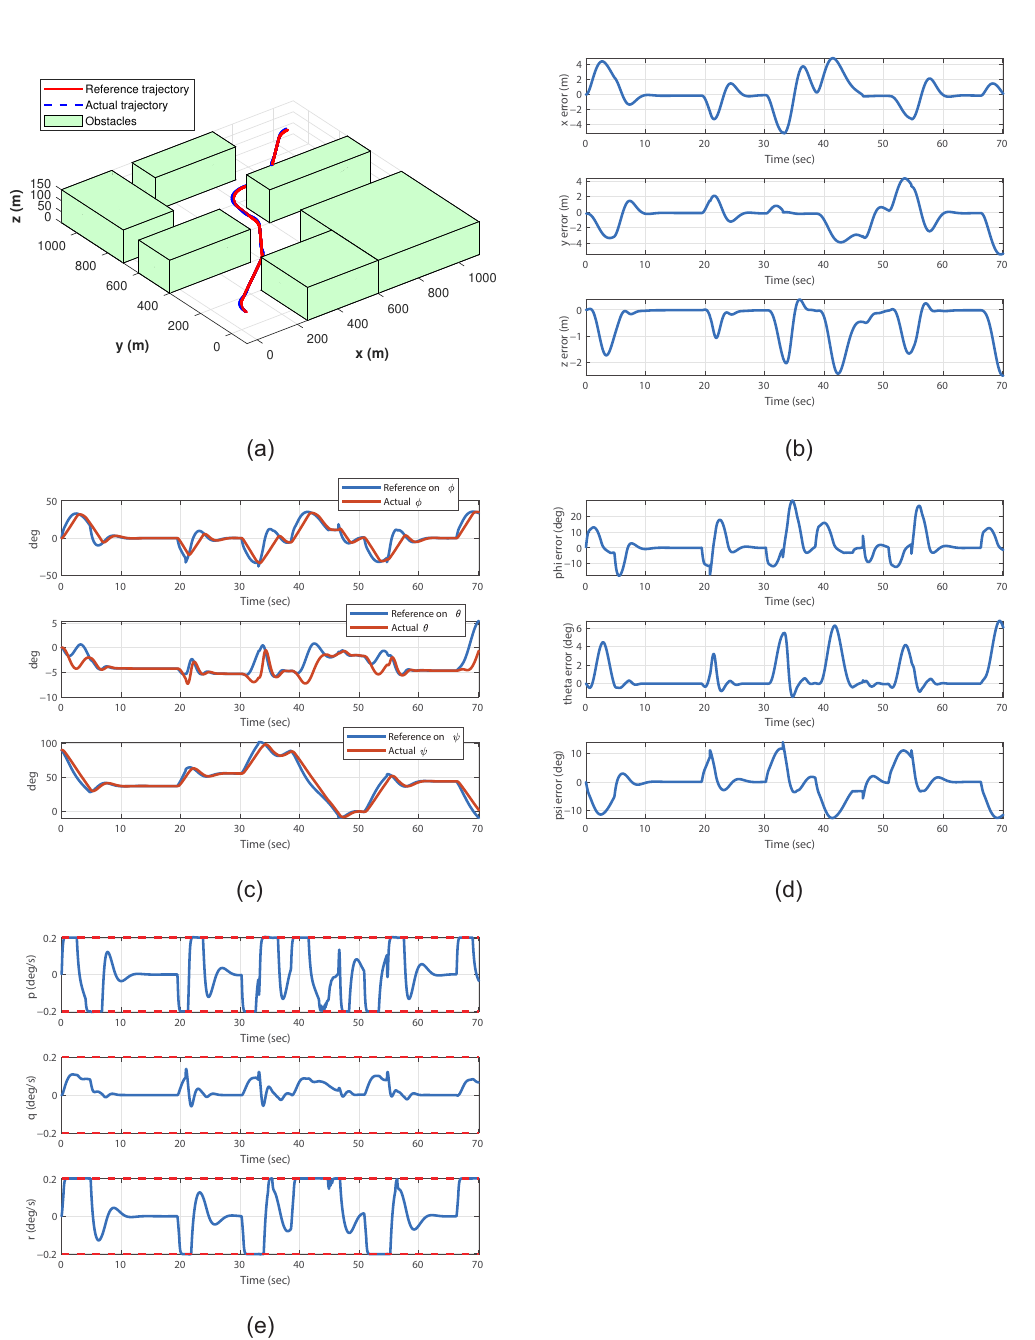
Figure 15. Path tracking results of scattered obstacle: ( a ) Path tracked in 3D. ( b ) Position error. ( c ) Attitude. ( d ) Attitude error. ( e ) Constrained angular